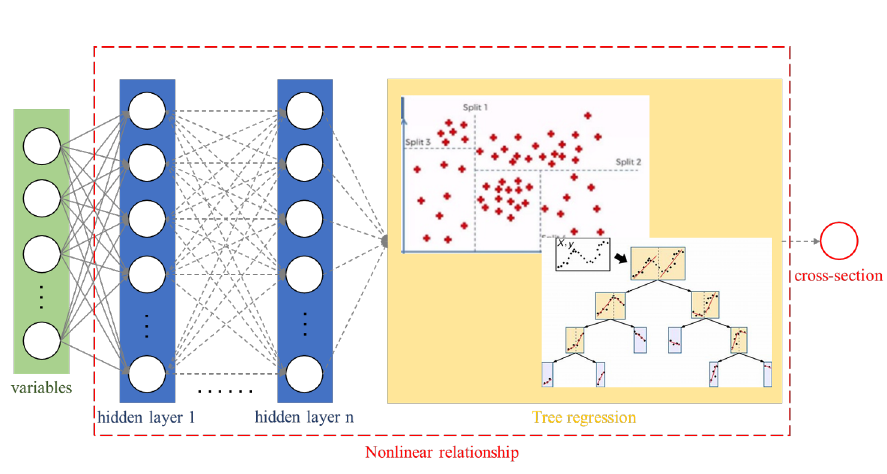
Figure 3. The architecture of proposed